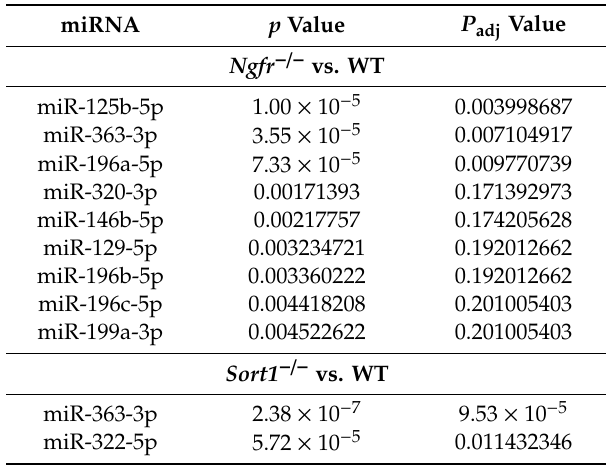
Table 8. List of miRNAs selected for target prediction and pathway analysis. miRNA p Value P adj Value Ngfr − / − vs.